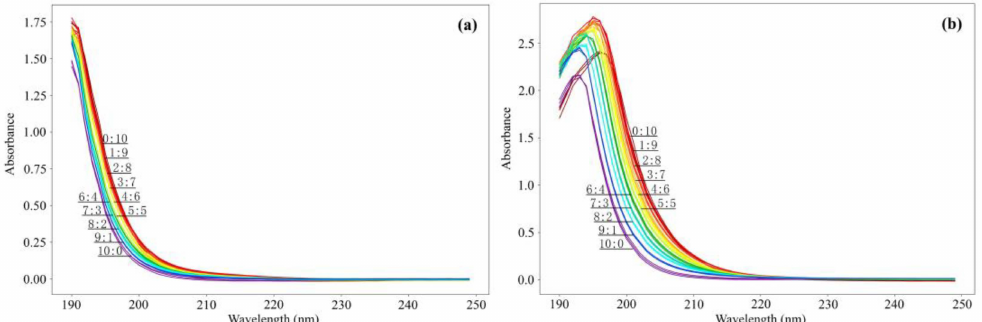
Figure 4. Scattering correction diagram. ( a ) Spectra of H-1 and H-2 mixed water samples, ( b ) Spectra of H-3 and H-4 mixed water